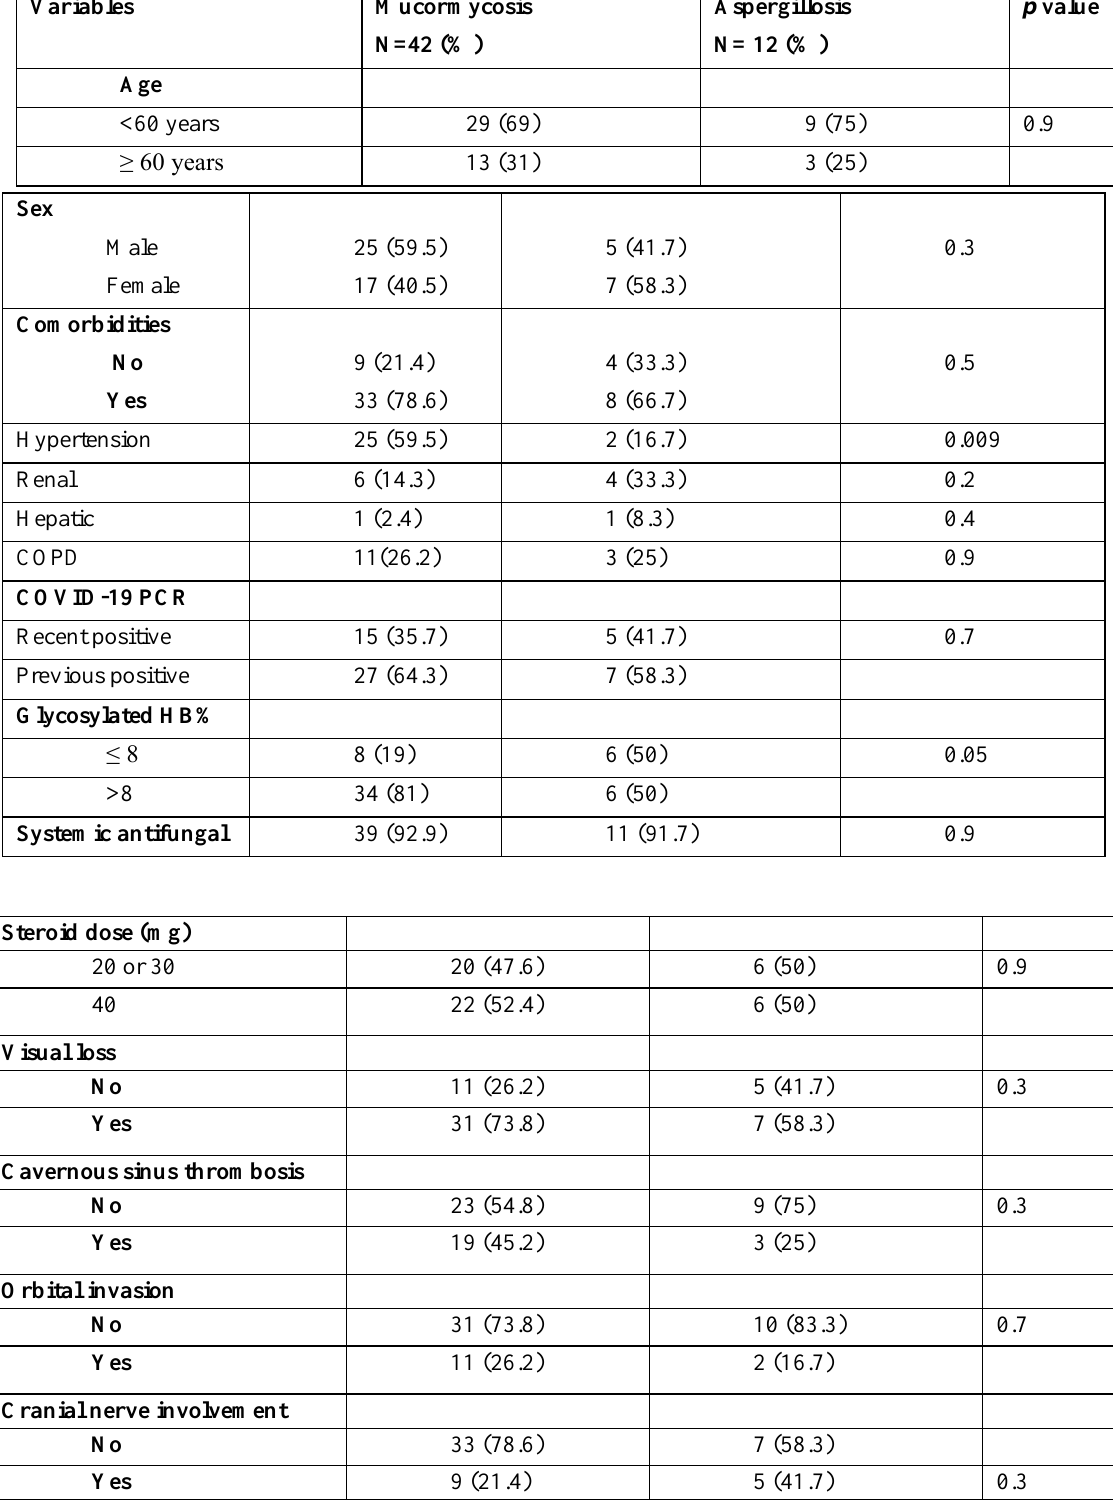
Table 3. Sociodemographic and clinical profile of mucormycosis and aspergillosis patients